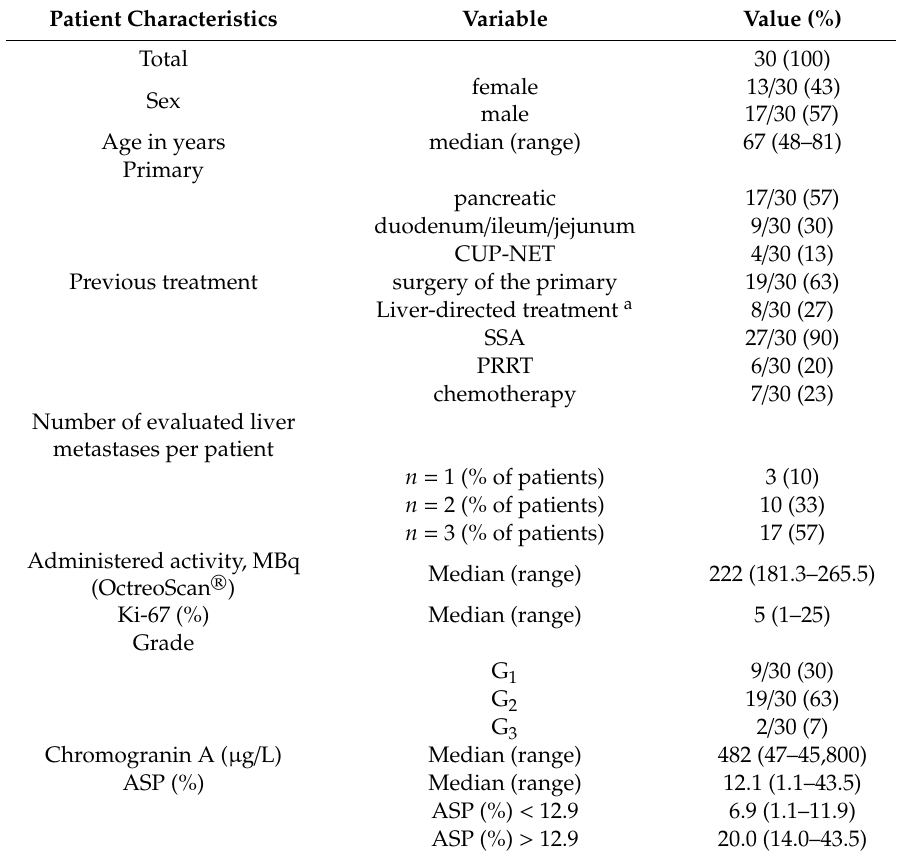
Table 1. Patient data and